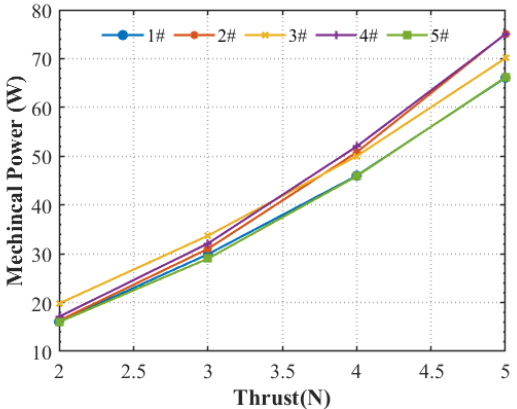
Figure 5. Comparison of mechanical power vs. thrust at four stable thrusts of five propellers.